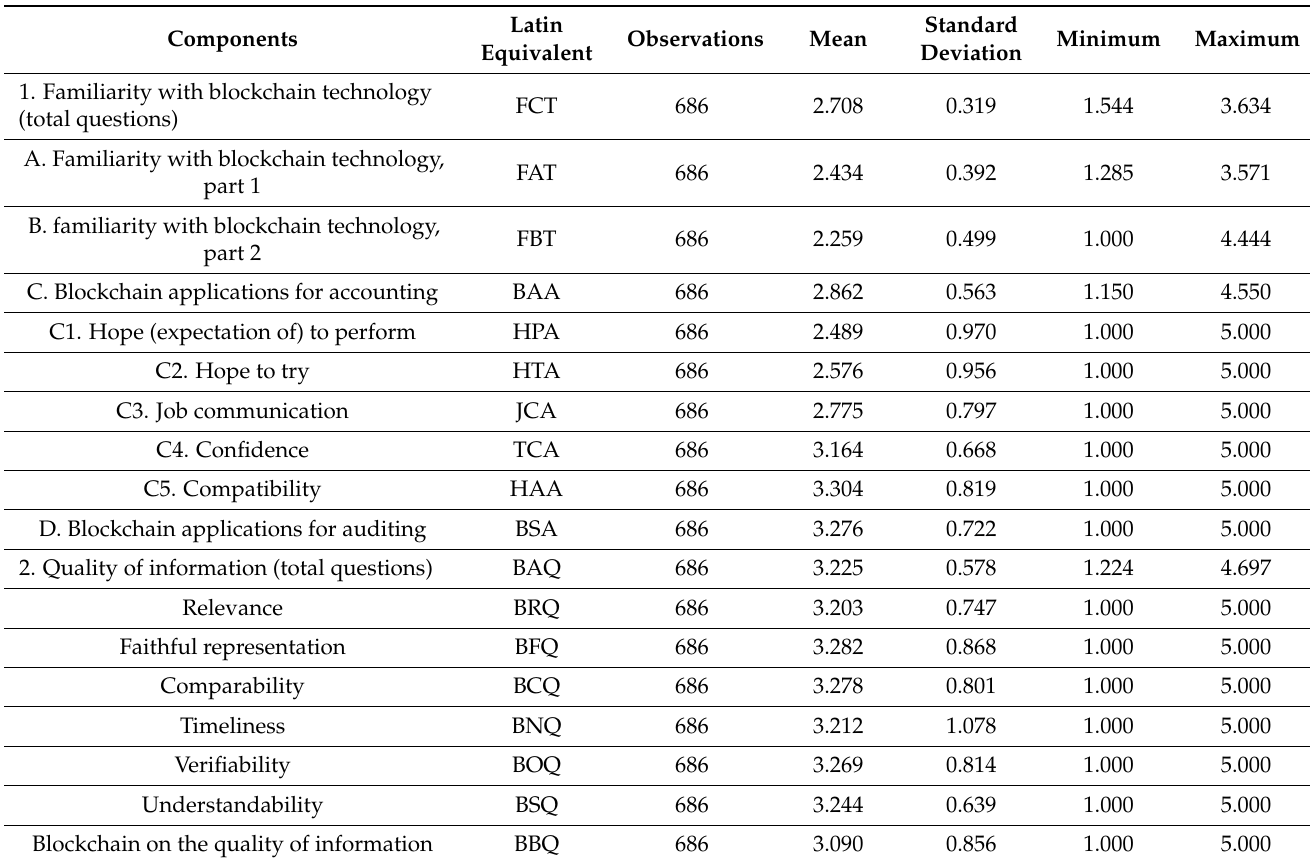
Table 6. The descriptive statistics of the data for non-listed